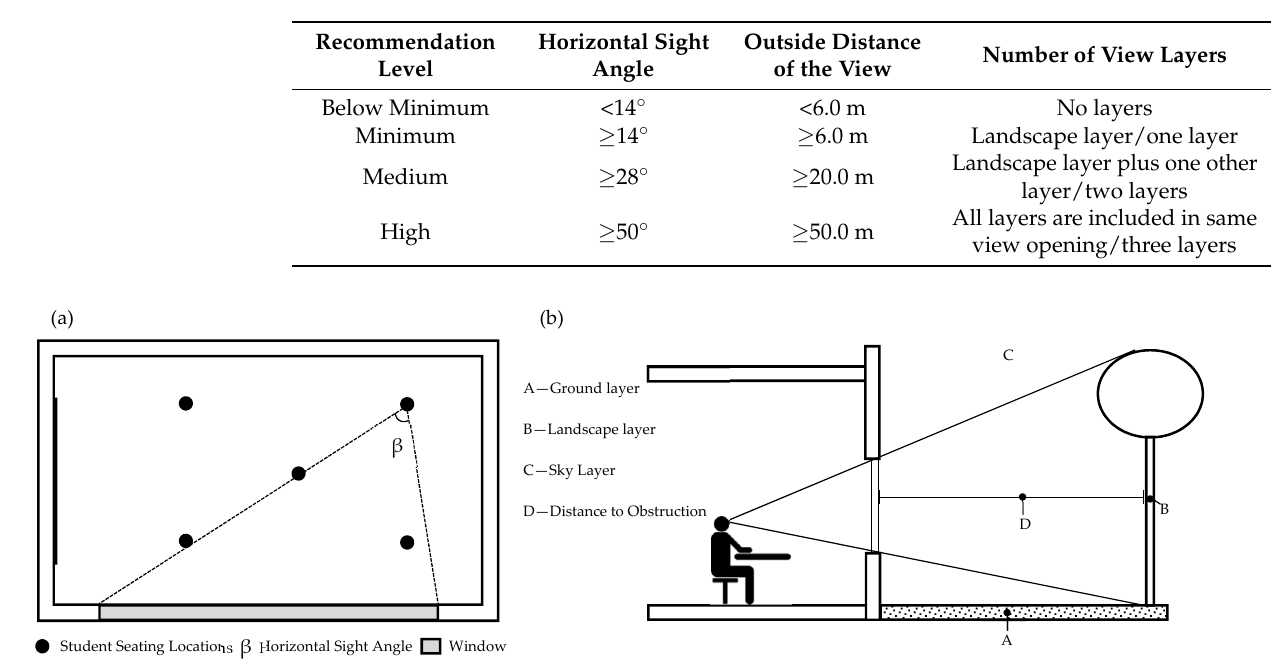
Table 1. Assessment of View Outwards—Information from EN17037.